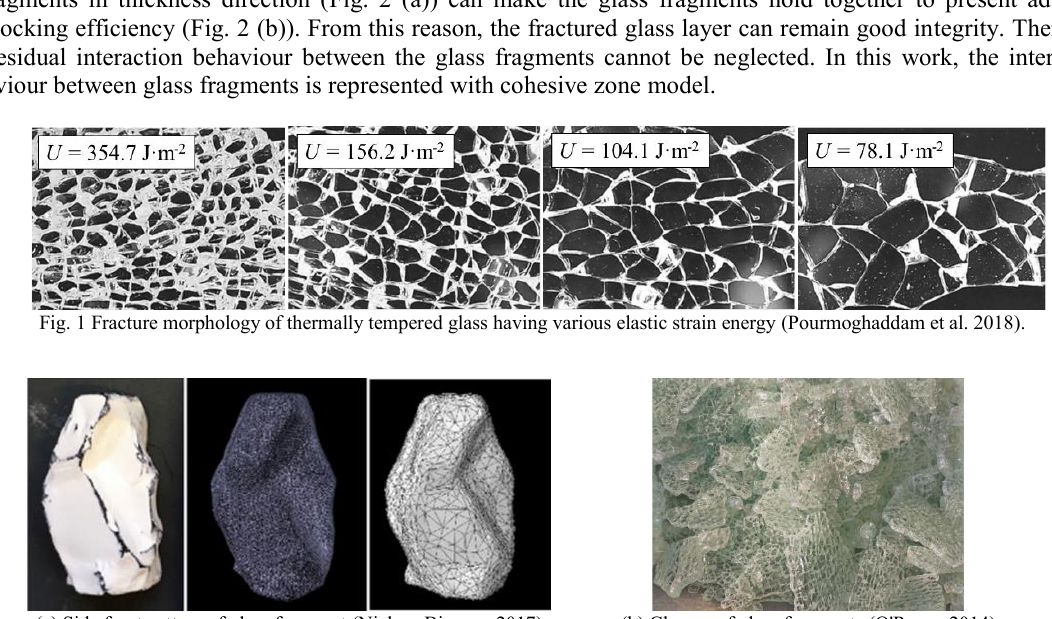
(a) Side facet pattern of glass fragment (Nielsen,Bjarrum 2017) Fig. 2 The irregular side facet pattern and interlocked clumps of tempered glass